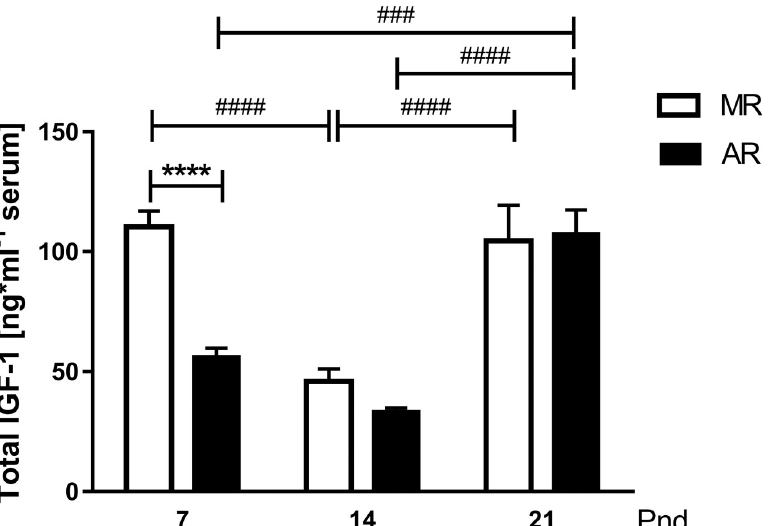
Fig 6. IGF1 serum concentrations in MR and AR pups at pnd7, pnd14 and pnd21. The growth factor was measured individually, n = 6. Differences in circulating IGF1 levels were compared by 2 way-ANOVA, followed by Tukey´s multiple comparisons posttest for differences between ages in both groups, ### P < 0.001, #### P < 0.0001, and by Sidak´s multiple comparisons posttest for differences between MR and AR groups, ���� P < 0.0001.